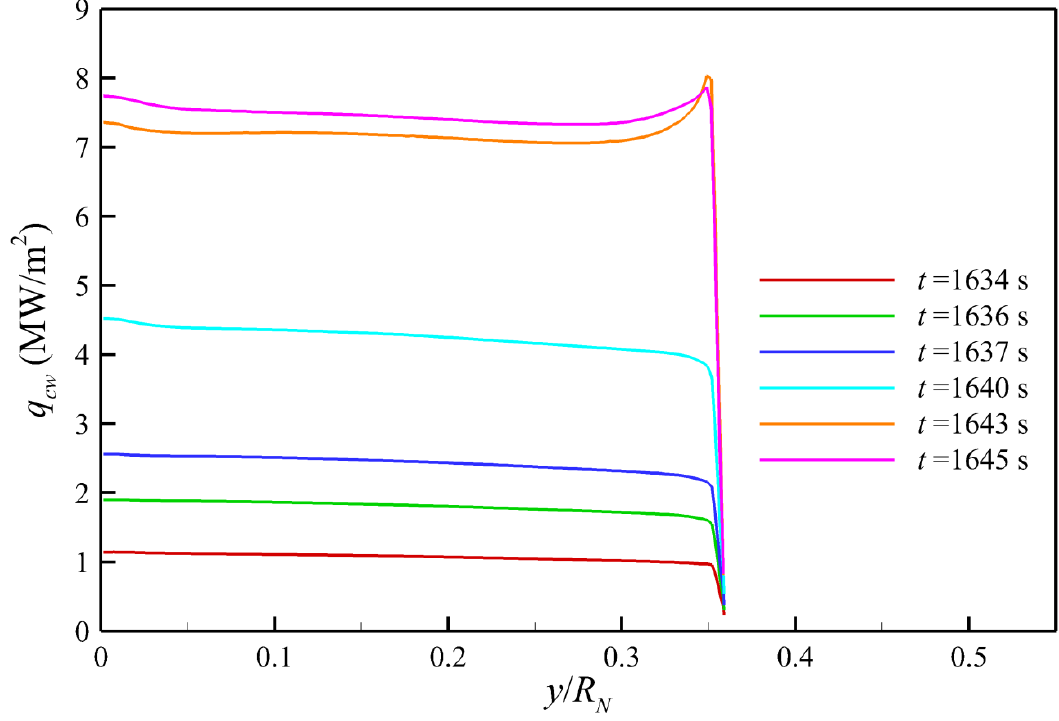
Figure 3. Forebody convective heating along the Fire II surface throughout the trajectory from t = 1634 s to t = 1645 s.